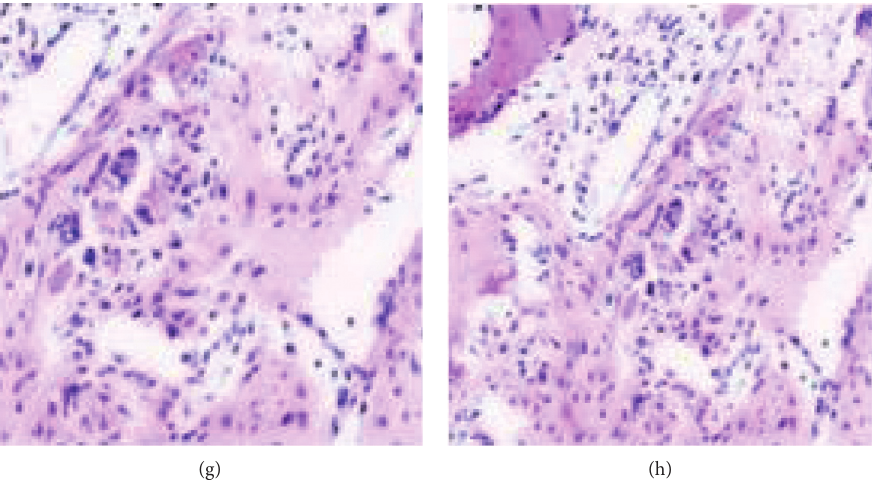
Figure 3: Comparison of bone histology of control (a), injection control (b), treated with 0.5 ml Al treated with 0.5 ml Al 2 O 3 nanoparticles (50 µ g/ml) (d), treated with 0.5 ml Al 2 O 3 nanoparticles (100 µ g/ml) (e), treated with 0.5 ml Al 2 O 3 nanoparticles (250 µ g/ml) (f), treated with 0.5 ml Al 2 O 3 nanoparticles (500 µ g/ml) (g), and treated with 0.5 ml Al 2 O 3 nanoparticles (1000 µ g/ml) (h) by H&E